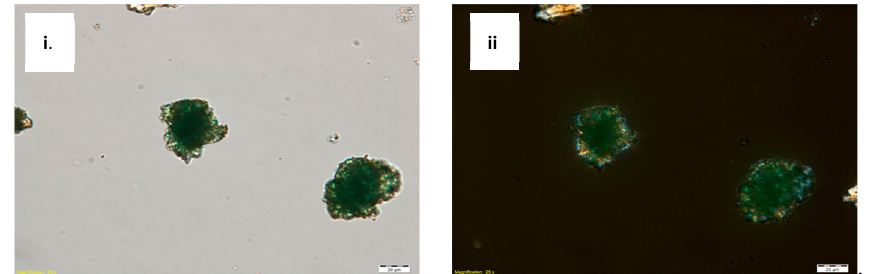
Figure 4. Dispersed sample of the pigments from LXT-04 at 500 × magnification in ( i ) plane polarized transmitted light and ( ii ) crossed-polarized light.